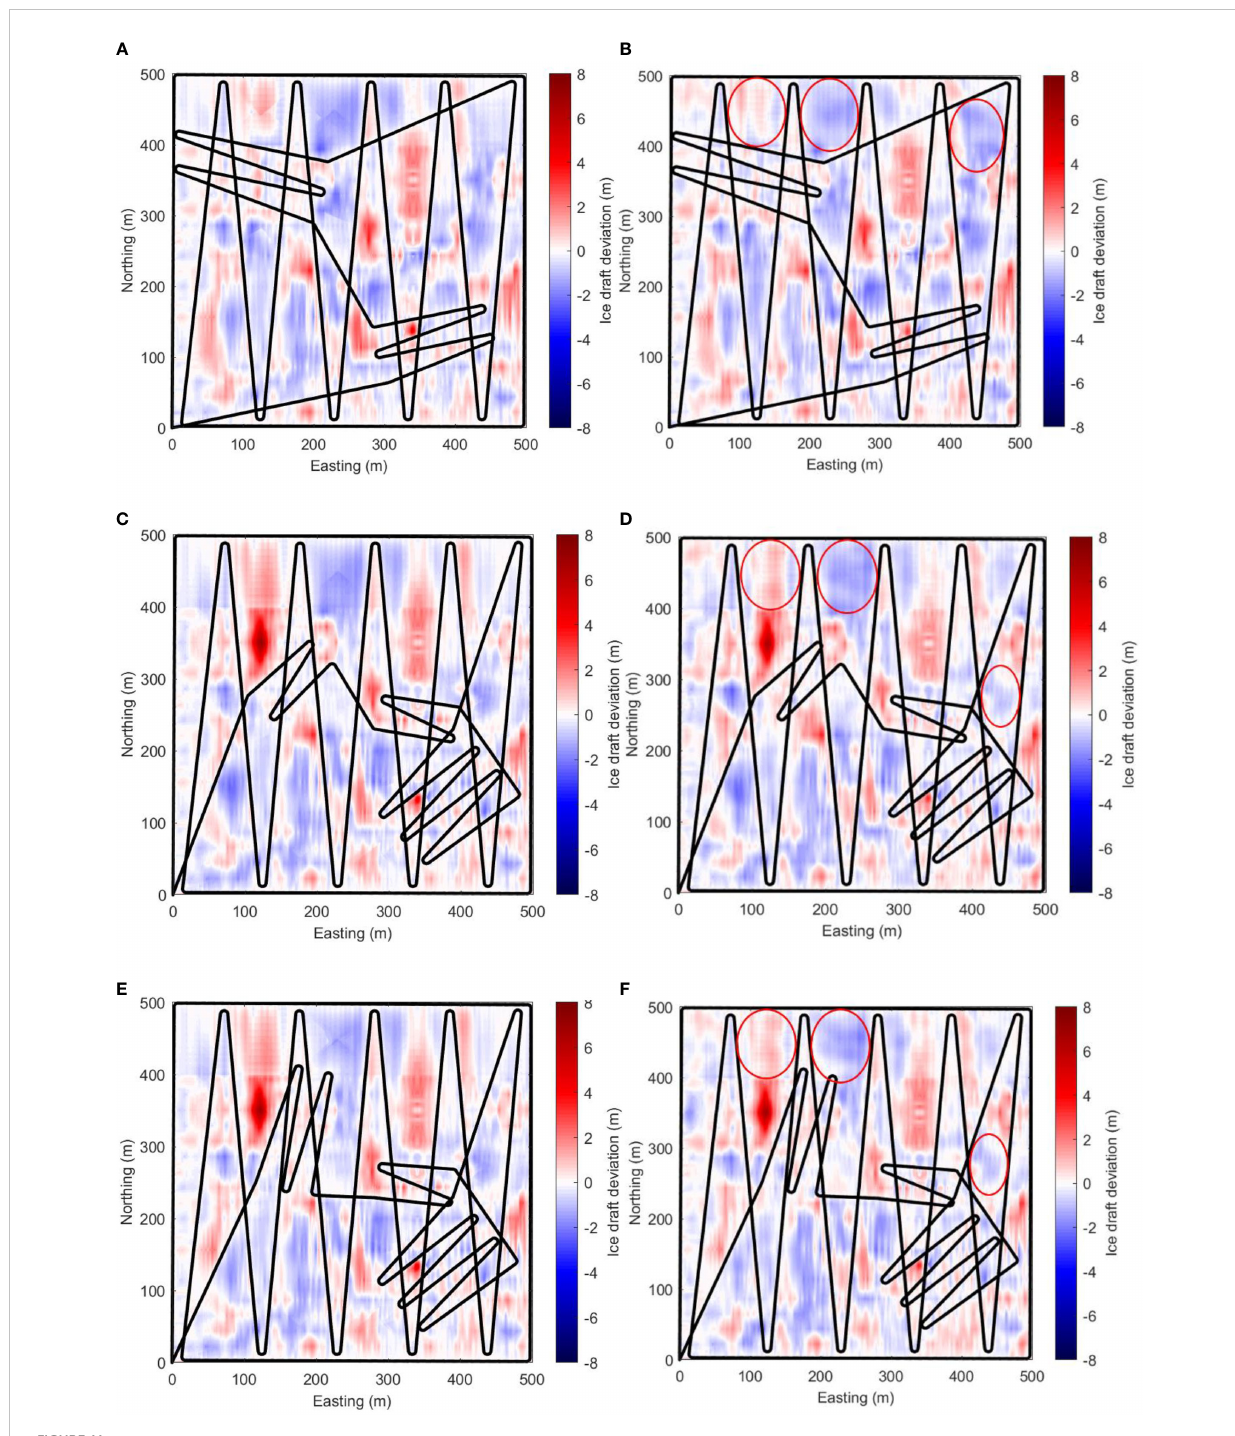
FIGURE 11 Deviation errors of different adaptive mapping and reconstruction methods (Red ellipses indicate the area for performance comparison). (A) Kriging interpolation under ice draft criterion. (B) Sparse approximation under ice draft criterion. (C) Kriging interpolation under ice draft gradient criterion. (D) Sparse approximation under ice draft gradient criterion. (E) Kriging interpolation under ice draft entropy criterion. (F) Sparse approximation under ice draft entropy